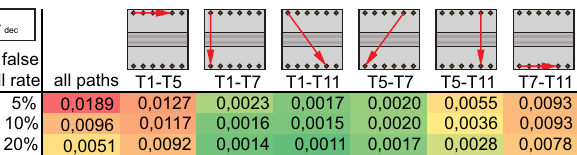
Figure 12. Resulting threshold values a dec based on empirical cumulative distribution of damage index values given for the cumulative empirical cdf of all paths and cdfs of exemplary paths. The fields are colored according to their value; small values are colored green, and high values are colored red.